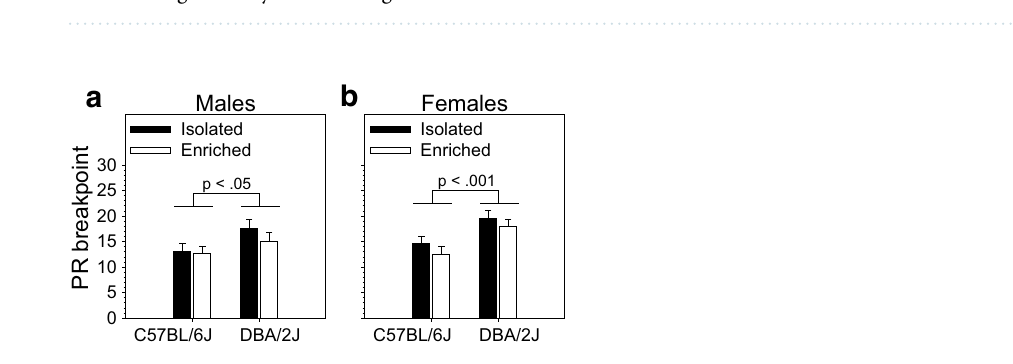
Figure 2. OSS on an FR-1 schedule was significantly influenced by housing condition, strain, and sex in C57BL/6J and DBA/2J mice. Across 18 FR-1 sessions, mice exhibited a significant preference for the active lever ( p < .001), and this effect was significantly influenced by housing condition, strain, and sex. ( a ) The Housing × Lever interaction was driven by a significantly stronger dissociation between the active lever and inactive lever in enriched relative to isolated mice. The pattern of lever pressing was such that enriched mice had a stronger preference for the active lever relative to isolated mice. ( b ) The Strain × Lever interaction was driven by the production of a significantly greater number of active but not inactive lever presses by DBA/2J mice relative to C57BL/6J mice. ( c ) The Sex × Lever interaction was driven by the production of a significantly greater number of active but not inactive lever presses in female mice relative to male mice. Notably, neither strain nor sex interacted significantly with housing condition on the FR-1 schedule.